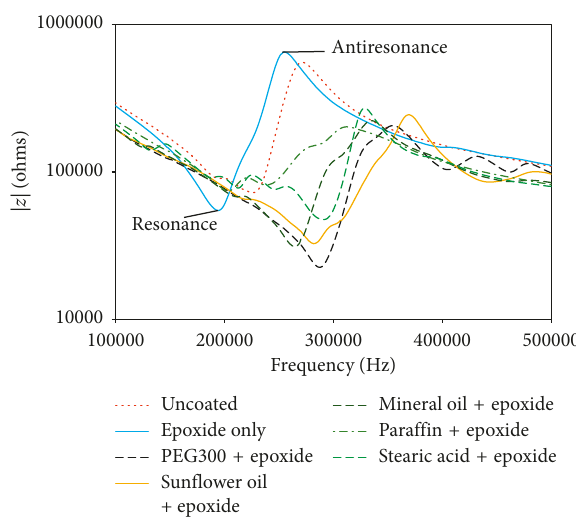
Figure 7: The Bode plot of the frequency response of the 1–3, 1-1-3, and 1-1-1-3 PZT-based composite